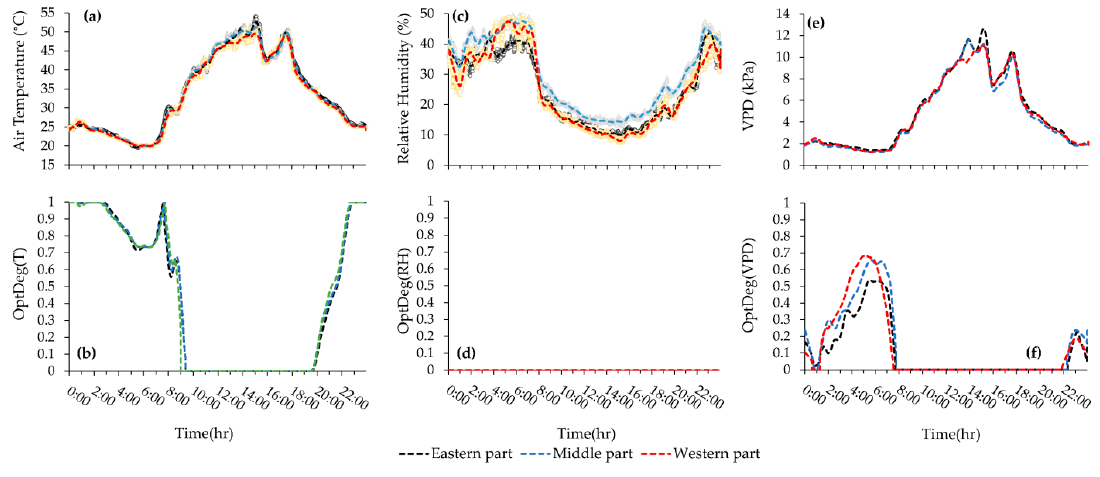
Figure 11. Hourly average variations of microclimate parameters and OptDeg at 29 July 2018. ( a ) air temperature; ( b ) OptDeg(T); ( c ) relative humidity; ( d ) OptDeg(RH); ( e ) vapor pressure deficit and ( f ) OptDeg(VPD).